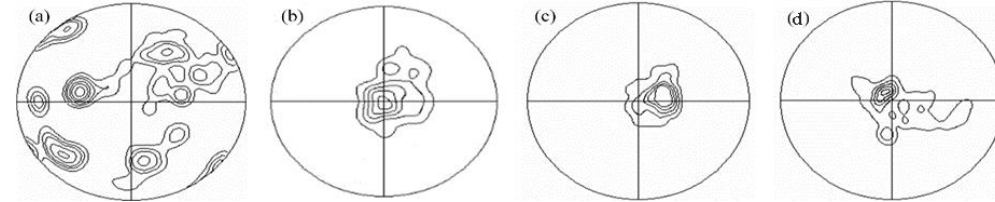
Figure 8. The {0001} basal pole figures: ( a ) cast states of MIMC; ( b ) extruded state of MISC; ( c ) extruded state of MITC; ( d ) extruded state of MIAC.